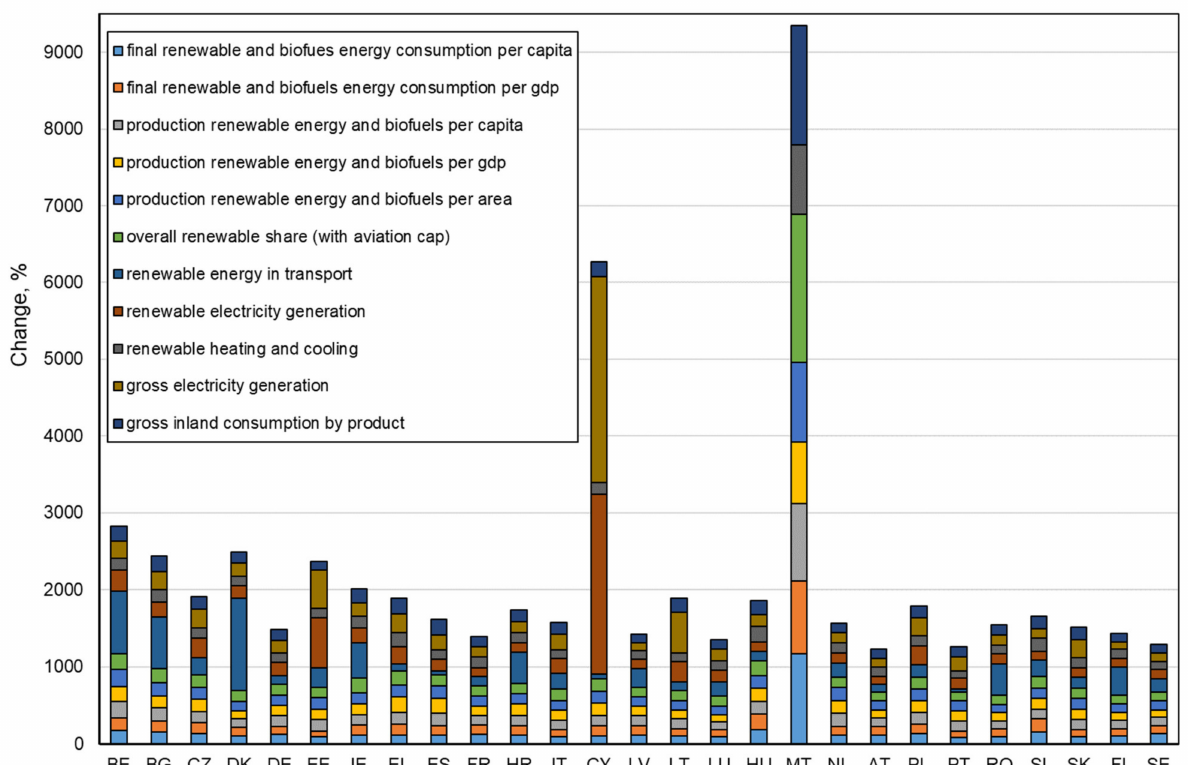
Figure 1. Percentage changes in the values of renewable energy indicators between 2008–2013 in individual EU countries (BE—Belgium, BG—Bulgaria, CZ—Czech Republic, DK—Denmark, DE—Germany, EE—Estonia, IE—Ireland,